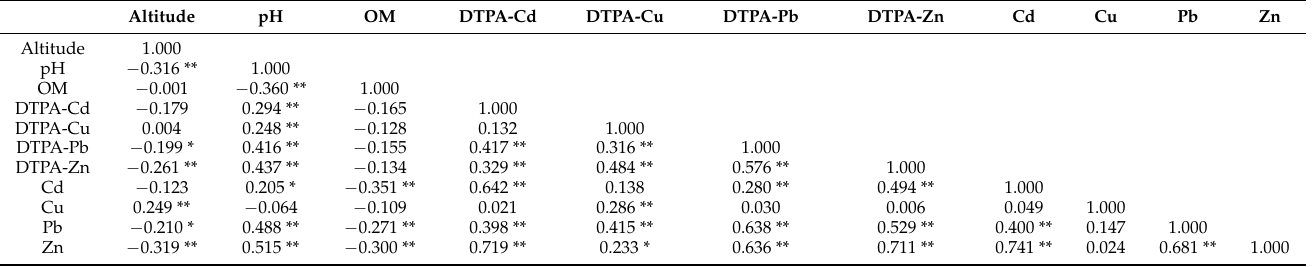
Table 4. Correlation analysis between altitude, pH, heavy metal content and OM content of